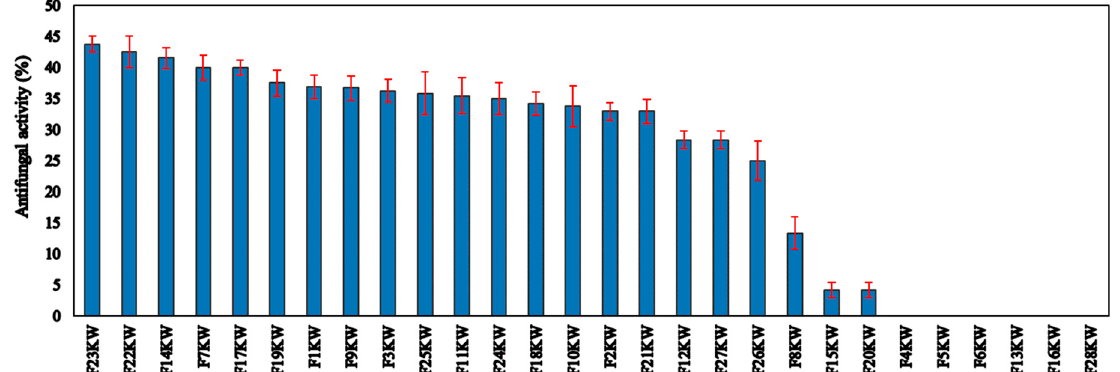
Figure 1. The antifungal activity of the isolated endophyte bacteria against R. solani. Red line is the standard deviation of the mean of the antifungal activity of the tested bacteria